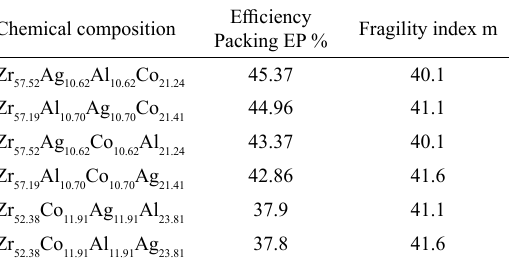
Figure 4: EDX Mapping of Zr cross-section. Table 1: Compositions, packaging efficiency and fragility index in Zr-Co-Al-Ag system Chemical